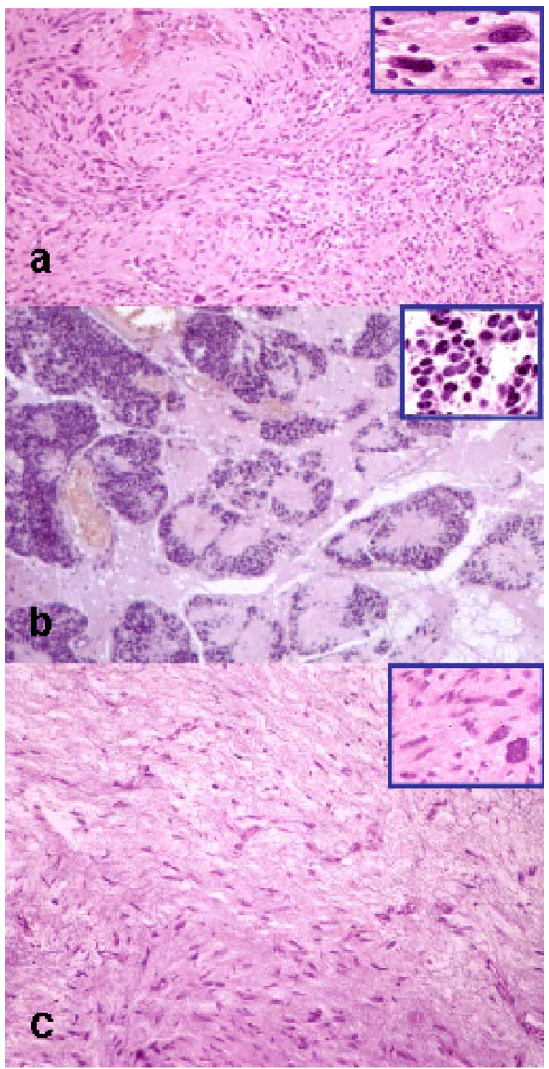
Fig. 1. (a) Ancient schwannoma with characteristic pleomorphic cells (insert) causing diagnostic difficulties. Case number: 18. (b) Neuroblastoma like schwannoma. Note the modified Verocay bodies as giant rosettes and the uniform small round tumor cells (in- sert). Case number: 25. (c) Atypical-cellular neurofibroma. This tu- mor had no capsule and displayed strong but focal S-100 positivity. Note the cellular area and the atypical tumor cells in insert. Case number: